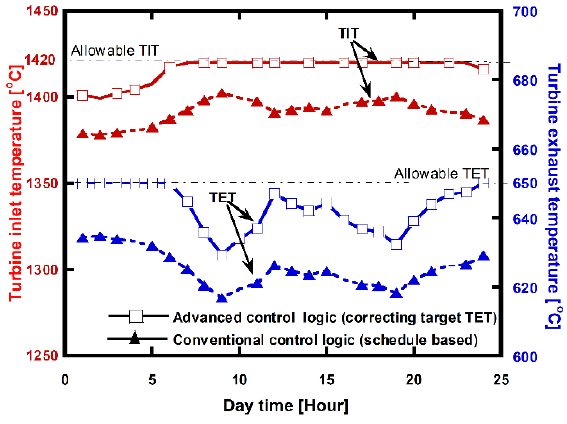
Figure 15. Variations in power production and efficiency of the gas turbine during a day.